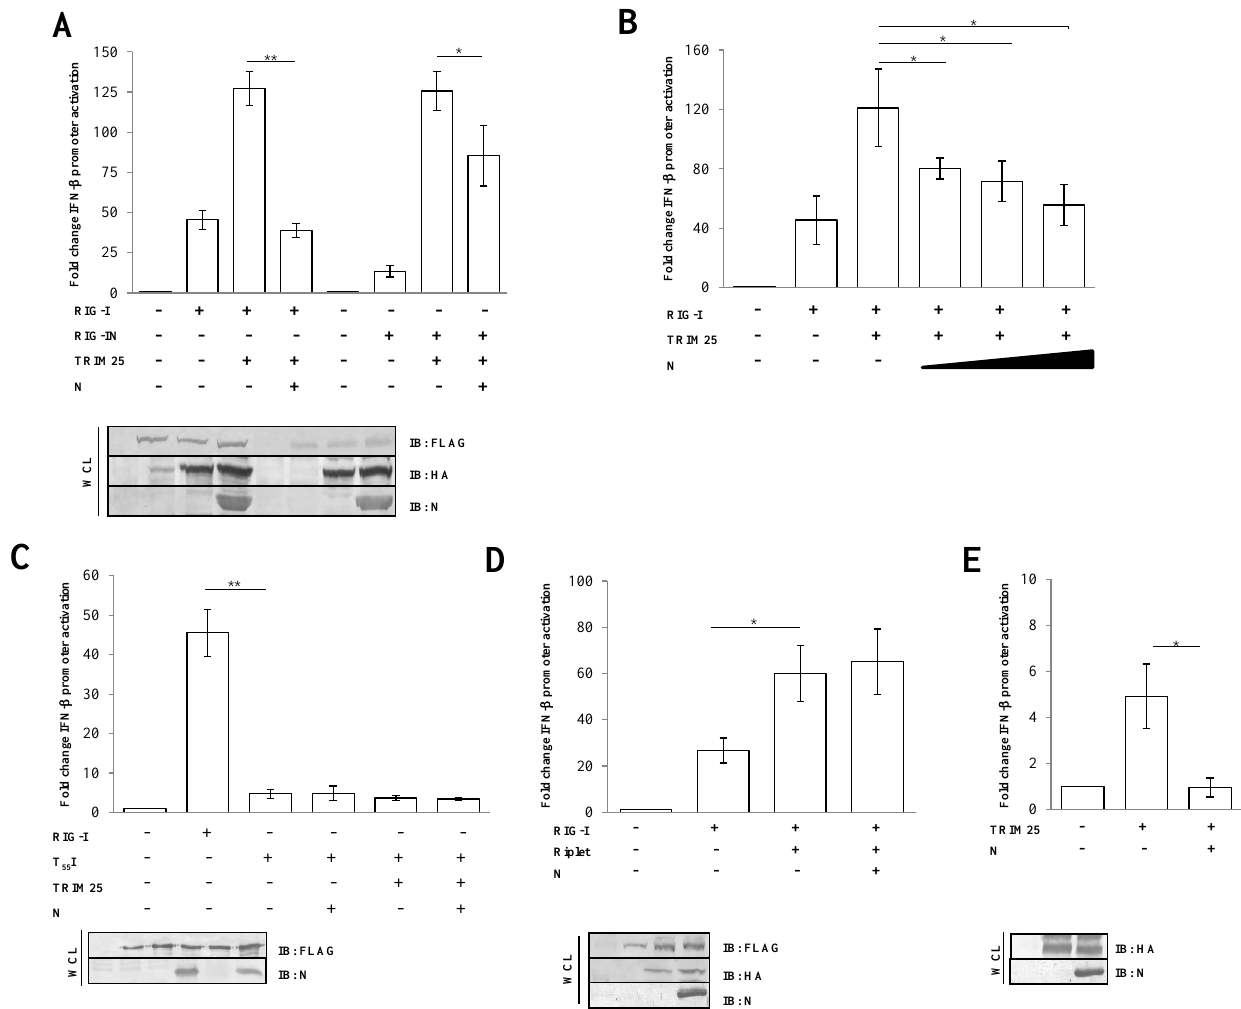
Figure 2. SARS-CoV-2 N protein inhibits TRIM25-mediated RIG-I activation to counteract IFN- β secretion. Lenti-X 293T cells were co-transfected with the IFN- β -Luc Firefly luciferase reporter plasmid and the Renilla luciferase control reporter plasmid along with RIG-I- and TRIM25-expressing plasmids. Where indicated, fixed ( A ) or increasing ( B ) amounts of SARS-CoV-2 N were co-expressed. ( C ) Wild-type RIG-I was replaced by its T 55 I mutated counterpart. Cells were collected at 48 h post-transfection, prior to 12 h of stimulation with poly(I:C). The luciferase activity of the cell lysates was analyzed with the dual luciferase reporter assay system (Promega). Fold changes in IFN- β promoter activation were calculated with respect to the relative reference sample based on Firefly luciferase values normalized to Renilla luciferase activities. ( D ) The specificity of SARS-CoV-2 N on TRIM25 was achieved by enhancing RIG-I activation through the over-expression of the stimulatory protein Riplet or ( E ) solely on TRIM25 expression. Luciferase assays were assessed and the fold change in activation was calculated as previously described. Results were plotted as mean values ( n = 4) ± standard deviation (SD), and significance was determined by p -values 0.005 < ** p < 0.01, 0.01 < * p < 0.05). Cell lysates from reporter gene assays were analyzed by immunoblotting. Fifty micrograms of WCLs were loaded on SDS-PAGE and probed with specific monoclonal antibodies for protein